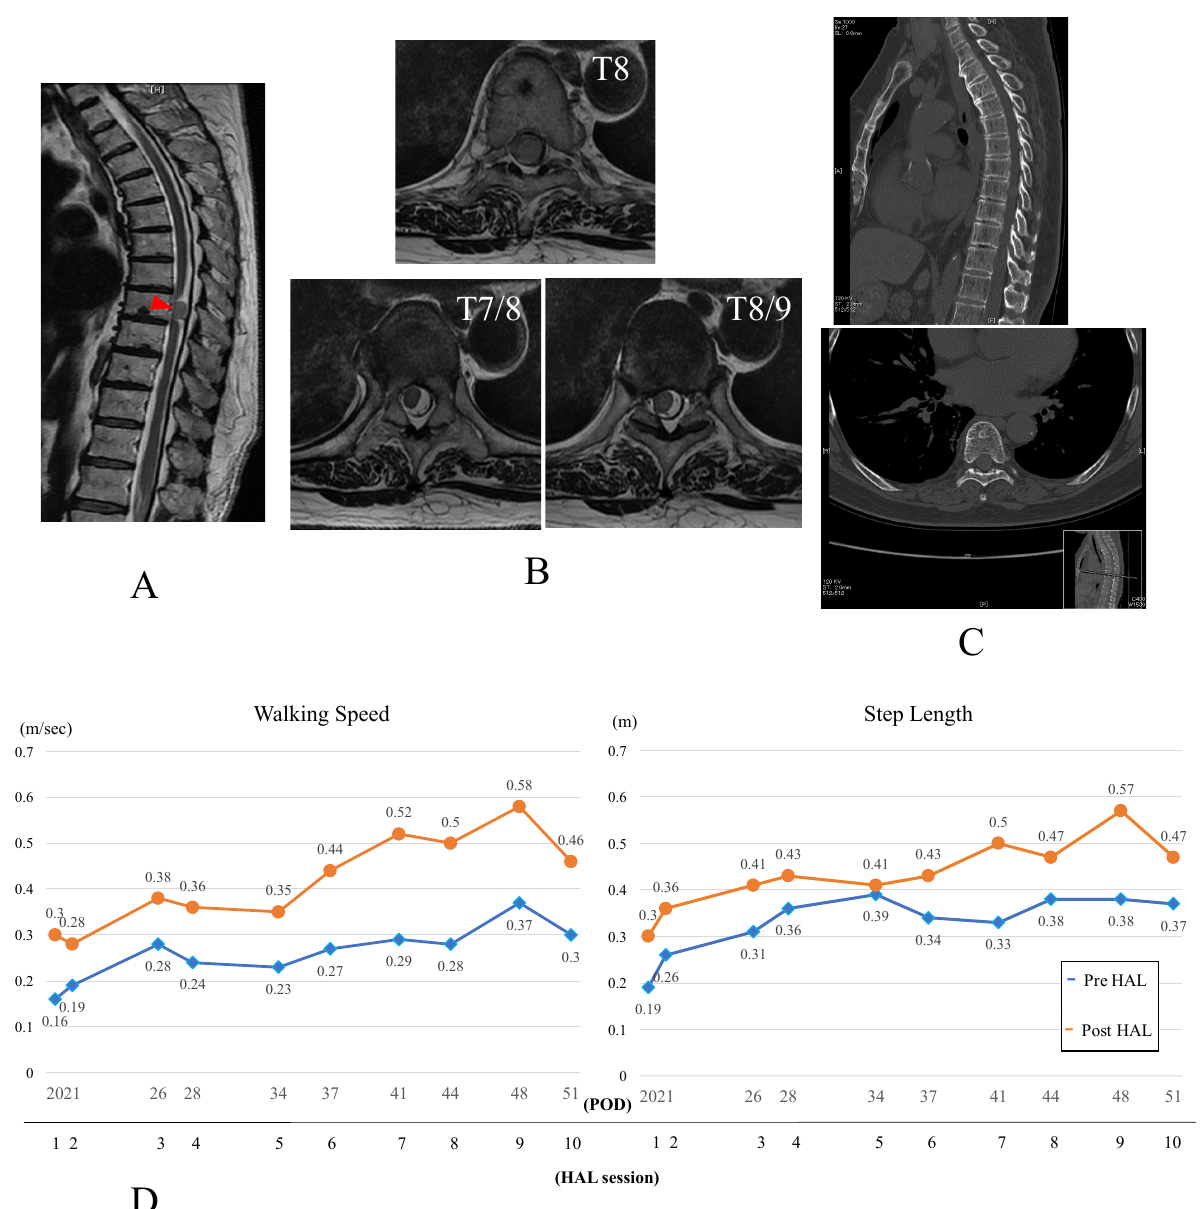
Figure 1. Mid-sagittal T2-weighted (T2WI) magnetic resonance image (MRI) of the thoracic spine region (T8, red arrow) ( A ) and coronal T2WI MRI scan, at the level of T7/8, T8, T8/9 ( B ). Sagittal and coronal computed tomography at the level of T8 ( C ). ( D ) Graph showing the chronological improvement in walking speed and step length in the 10 m walking test without the hybrid assistive limb (HAL) during the HAL gait sessions.